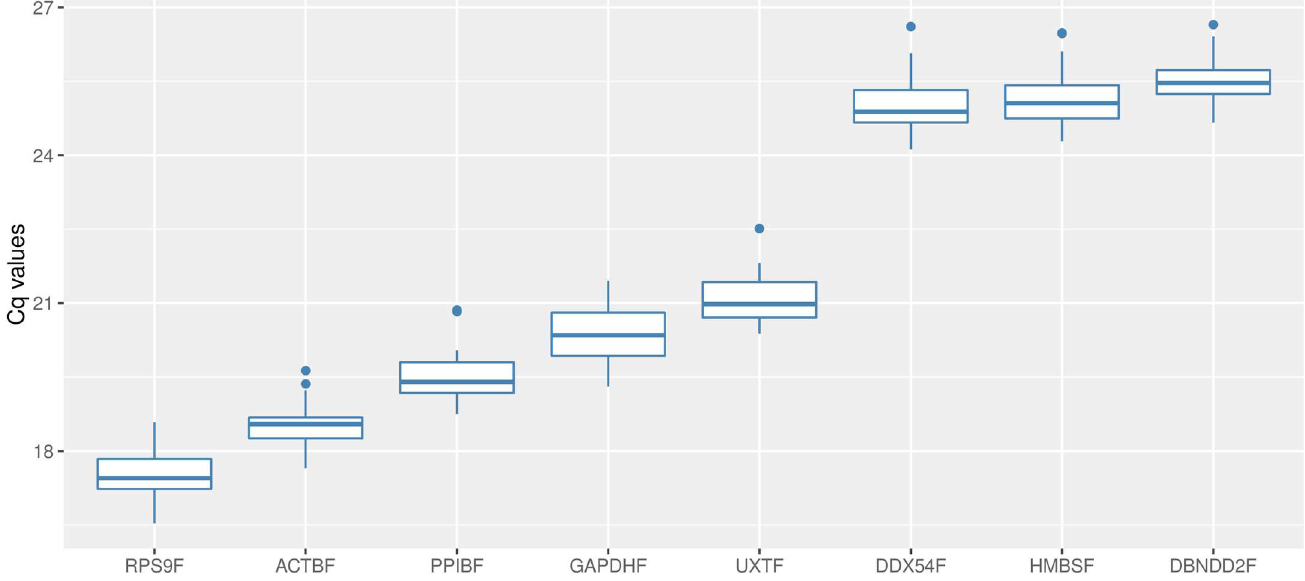
Fig 1. Boxplot of Cq values. Variationsof the quantification cycle are shown for all examinedreference genessorted by expressionrange (n = 30). Each box represents the 50% quartile; the medianis figured as the line in each box; whiskers depict the 25% minimum and maximum range of the Cq value.